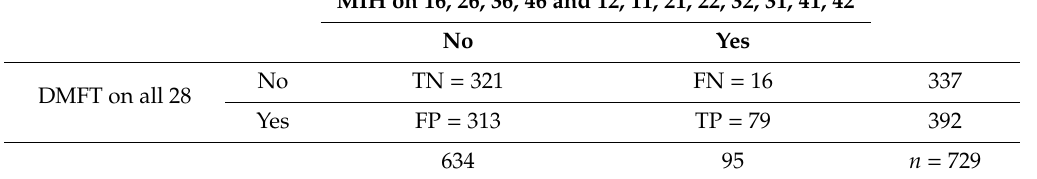
Table 3. The relationship between permanent tooth status Decayed, Missing, and Filled Teeth (DMFT) and